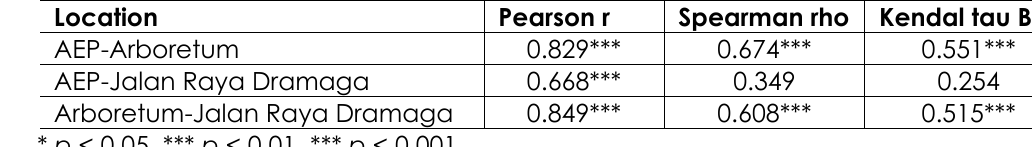
Table 2. Landscape Elements Correlation Analysis from Questionnaire